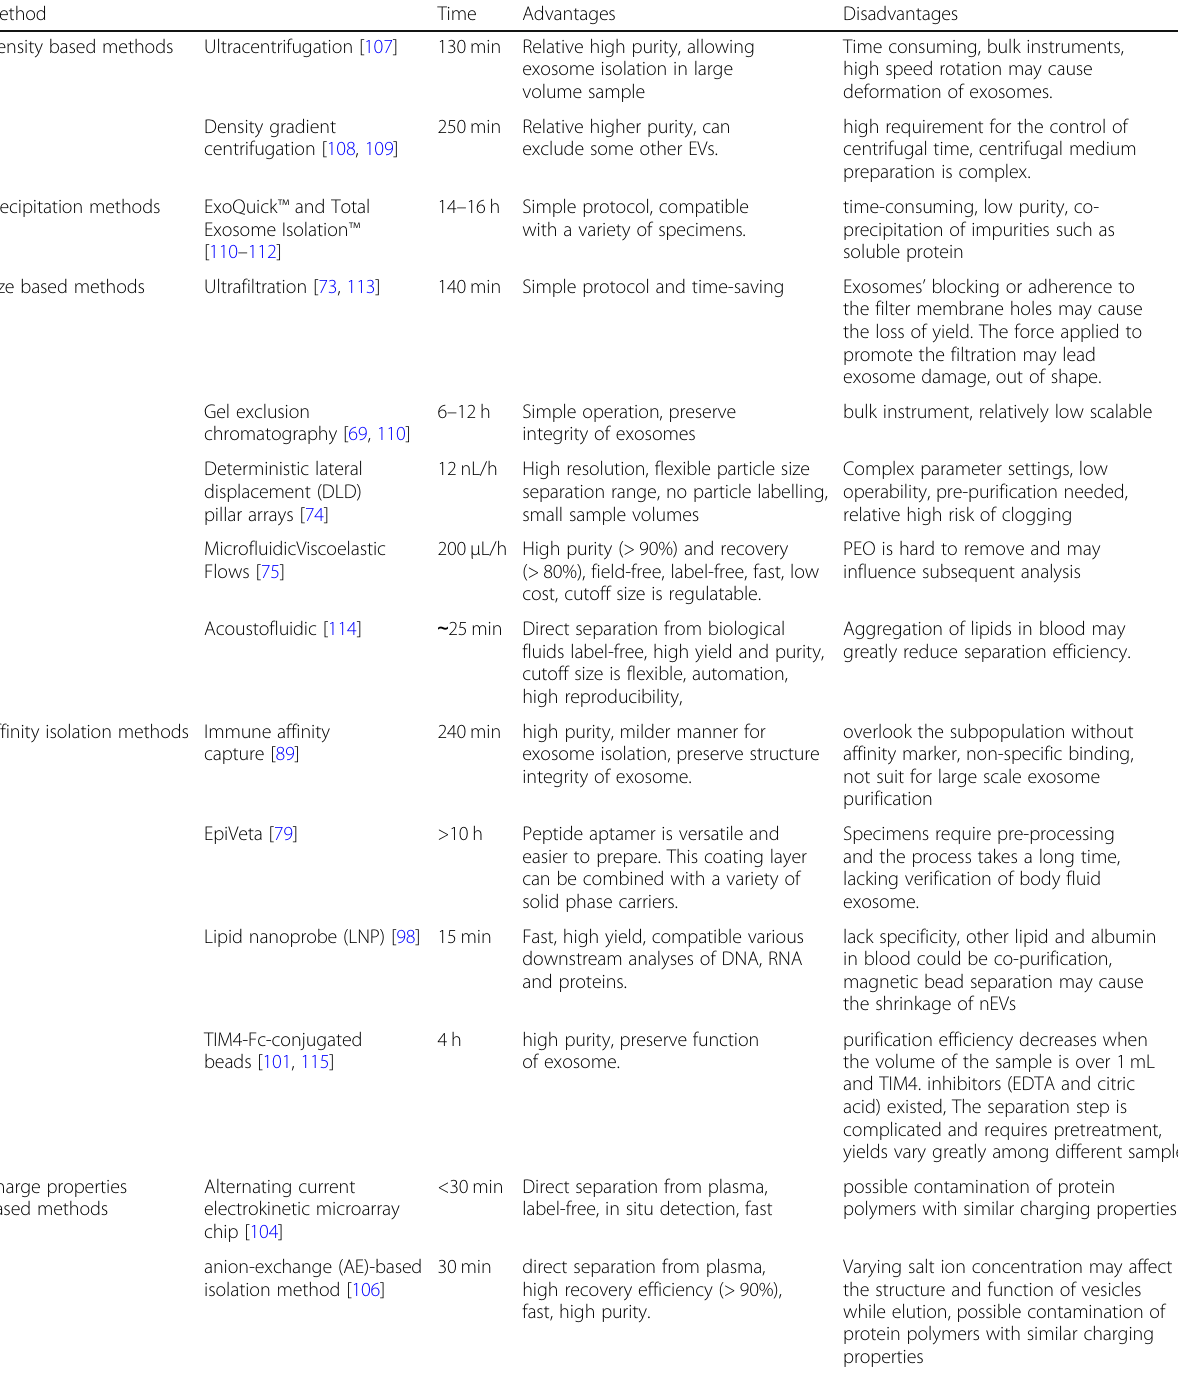
Table 3 Comparison of different exosome isolation methods